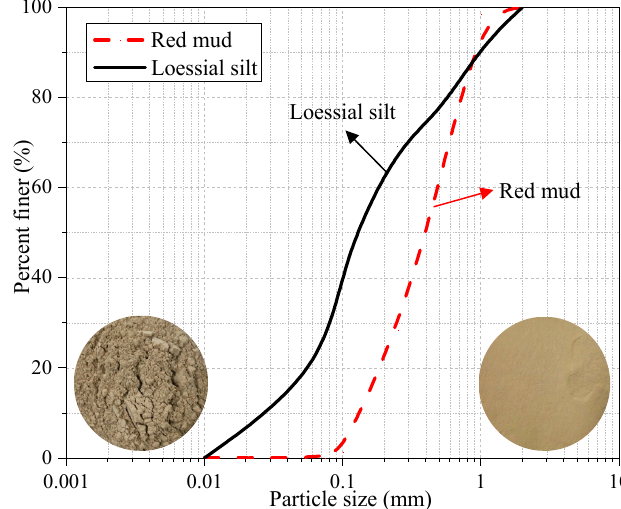
Figure 3. Particle size distribution of red mud and loessial silt.